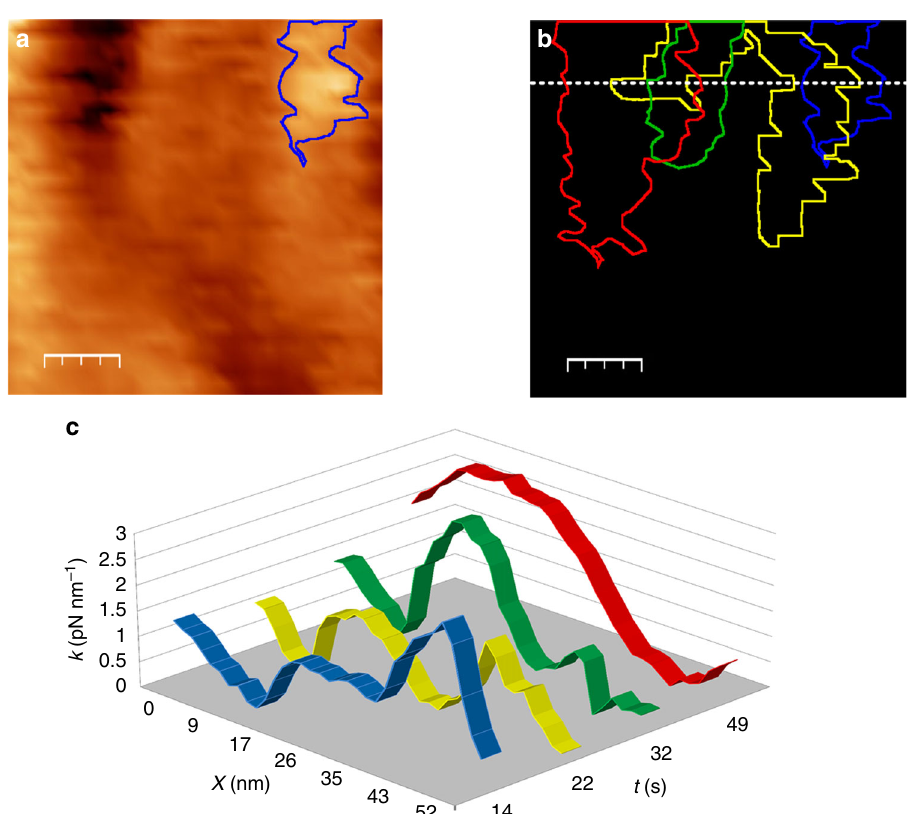
Fig. 4 Dynamic growth of a Cu nucleus on the ITO surface at constant overpotential. The force micrograph at 14 s after the potential step is shown in a , where a copper nucleus is highlighted in blue . Contours of the copper features at 14, 22, 32 and 49 s are presented in b , while c shows the shear-force as a function of time and position (over the dotted line in b ). The scale bars in a and b represent 12